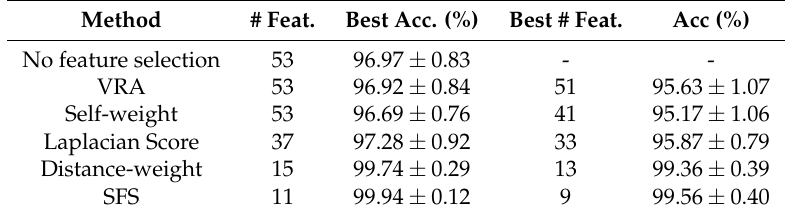
Figure 4. The learning curve results are shown for the feature rankers studied using an hidden Markov models (HMM) classifier. We present the average of the testing set performance under a nested 10-fold cross-validation strategy. Table 4. Best classification results and number of features required (four class problem).